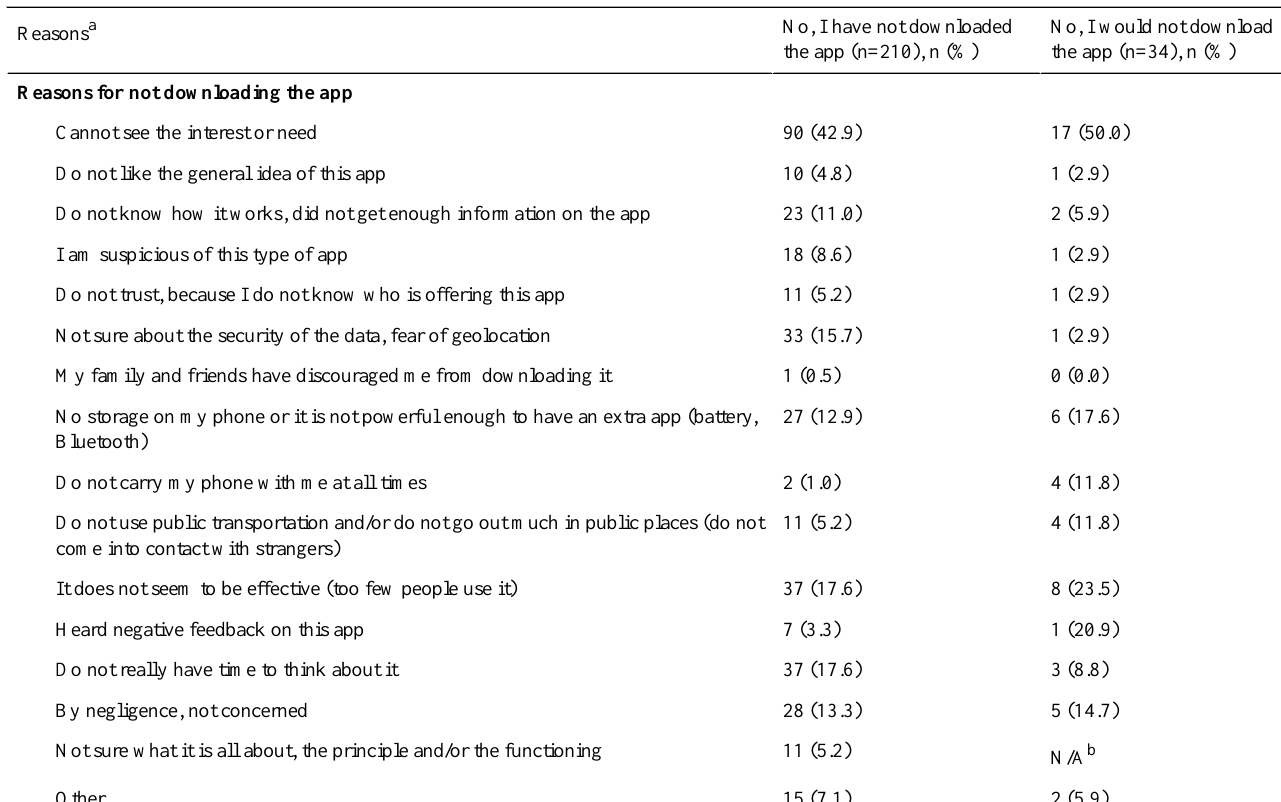
Table 3. Reasons for not downloading the StopCovid